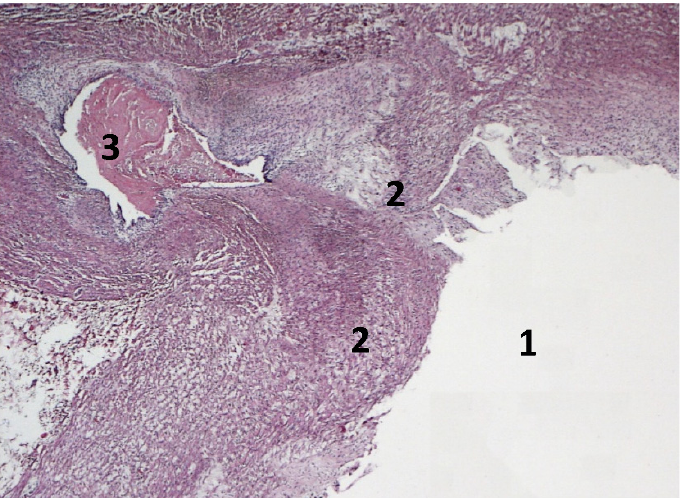
Figure 4. Histopathological image of the longitudinal section of the origin of the left pulmonary artery branch with its lumen (1). A thick layer of fibromyxoid tissue along the endothelium completely occludes the origin of the artery (2). In the residual cavity of the left branch, there is a voluminous thrombus (3). Hematoxylin & eosin stain. 2.5X. The final diagnosis was left PA coarctation associated with pneumonia, pre-capillary PH, and severe right-sided cardiac remodeling.